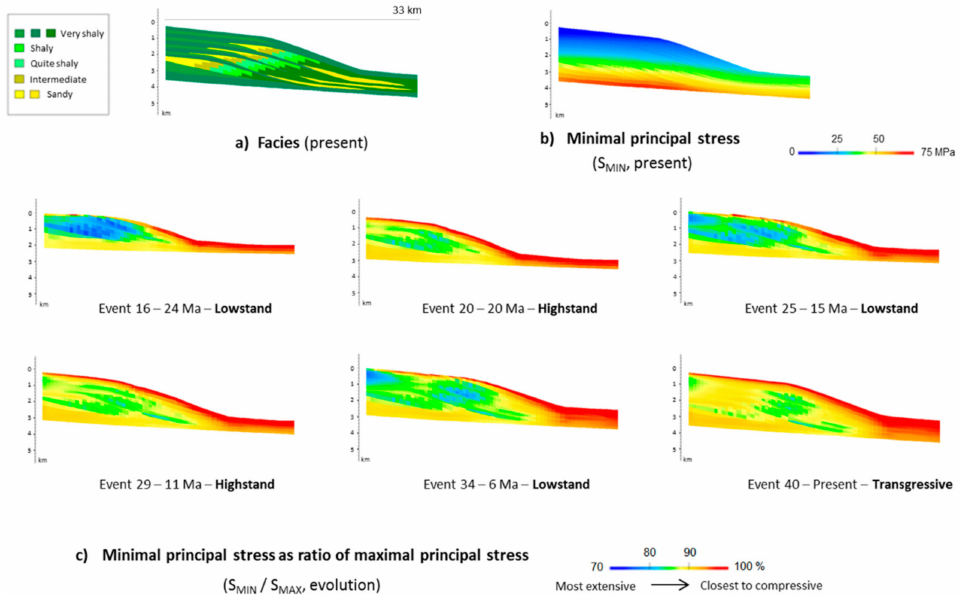
Figure 5. Minimal principal stress simulated on the base case scenario. ( a ) reminder of the lithological facies distribution; ( b ) present-day minimal principal stress: absolute values; ( c ) overview of the minimal principal stress evolution from six geological events: ratios of maximal principal stress; vertical exaggeration ×